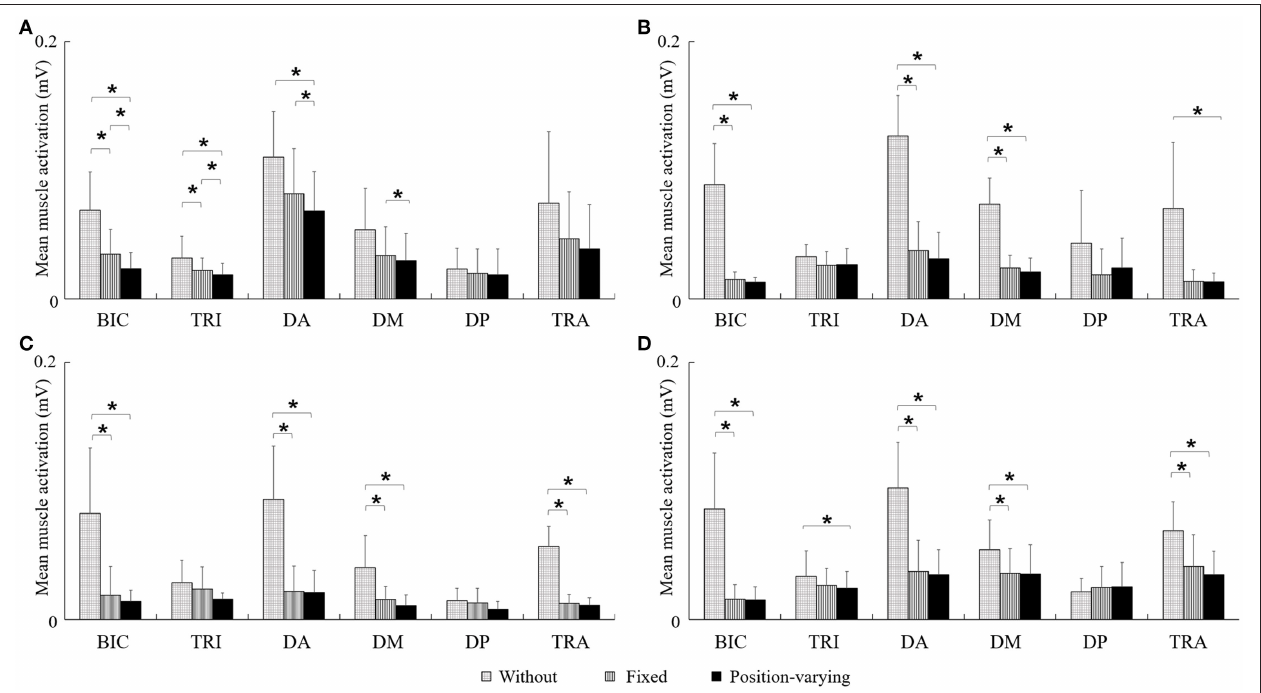
FIGURE 5 | The mean activation of six muscles during four direction movements with different gravity compensation strategies. *Significant difference was found between two kinds of gravity compensation strategies ( P < 0.05). (A) Upward, (B) Forward, (C) Leftward, and (D)